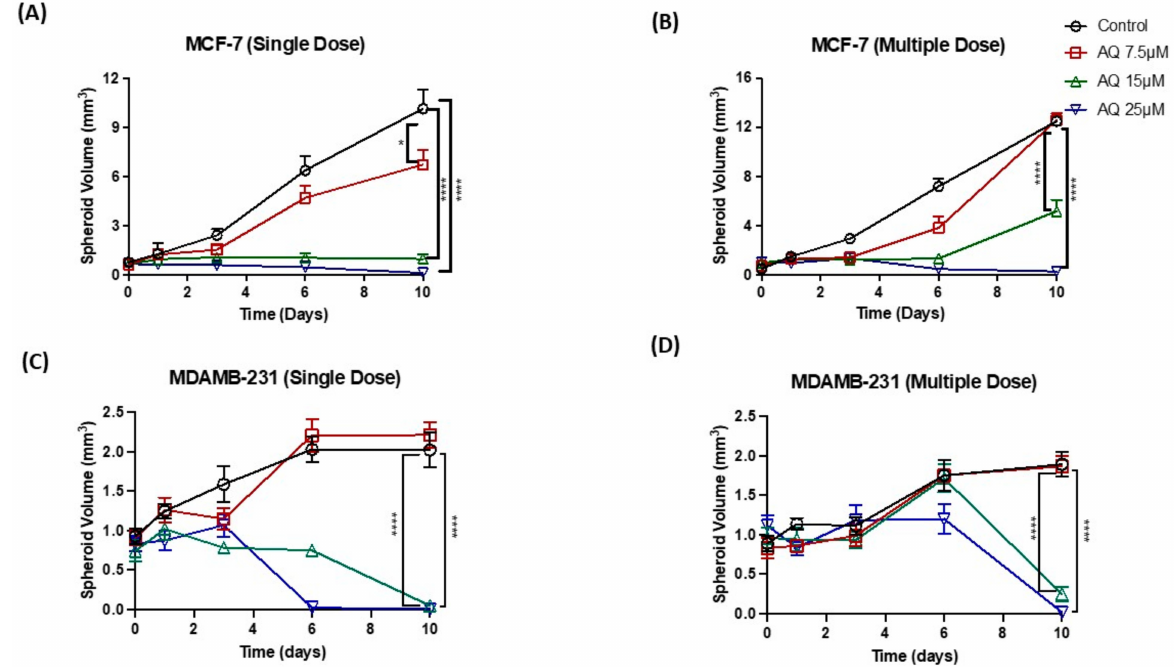
Figure 5. ( A , B ) Spheroid volume comparison plots for MCF-7 cell line. ( A ) Single dose. ( B ) Multiple dose. ( C , D ) Spheroid volume comparison plots for MCF-7 cell line. ( C ) Single dose. ( D ) Multiple dose. Data represent mean ± SEM ( n = 6). * p < 0.05, **** p <